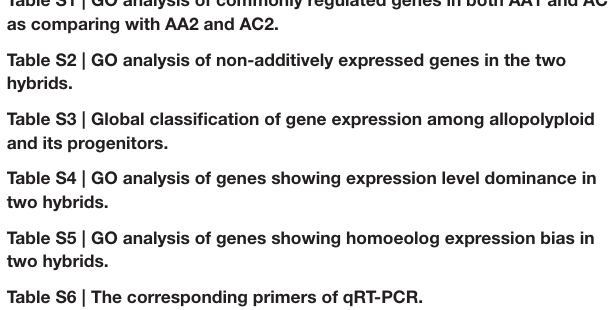
Figure S1 | The overall distribution of non-additively expressed genes along some chromosomes in AC1. The horizontal axis represents the physical location of each chromosome. The vertical axis represents the normalized fold change between AC1 and MPV. The red and blue points indicate the genes over-expressed or under-expressed in AC1 relative to MPV, respectively. Figure S2 | Cross comparisons of sets of additively and non-additively expressed genes in two synthetic hybrids. Numbers of genes shared between different expression patterns are indicated on the cross lines. Figure S3 | Cross comparisons of sets of differentially and non-differentially expressed genes revealed between synthetic hybrids and their relative A genome progenitors. Numbers of genes shared between different expression patterns are indicated on the cross lines. Figure S4 | Global classification of gene expressions among hybrid AC2 and its progenitors. Genes based on differentially or non-differentially among the hybrid, diploid progenitors, and MPV, were further classified into (A) 19 possible expression patterns (I—XIX; AA2 vs. CC, AA2 vs. AC2, AC2 vs. CC) and (B) 9 major expression categories (a–i; AC2 vs. MPV, AA2 vs. CC). Red, green and blue bars represent the confidence intervals of expression level observed in A and C genome progenitors and hybrid, respectively. A gene is differentially expressed between two samples when their confidence intervals (bars) do not overlap whereas it is equal when they do overlap. The x-axis represents the 19 possible expression patterns. The y-axis represents gene count. The number of genes for each expression pattern in each of expression categories is also indicated. Figure S5 | Comparison of the expression levels of genes showing expression level dominance in AC2. (A) The four expression level dominance patterns, for which the gene expression level in hybrid AC2 is statistically similar to one parent but different from the other parent. (B) The normalized expression values, measured in hybrid, the MPV and two progenitors, for genes from the four expression patterns are plotted to illustrate the expression level dominance. The y-axis represents log 2 of the expression level (FPKM). Genes are orders on the x-axis according to increasing FPKM of their MPV. The number of genes in each comparison is also indicated. Different colors indicate different species as described above, Red, AA2; green, CC; blue, AC2; purple, MPV. Figure S6 | qRT-PCR confirmation of the differentially expressed genes. Columns and bars represent the means and standard error from qRT-PCR ( n = 3), respectively. The average gene expression levels from two RNA-Seq replications are indicated on the bottom of each gene. Table S1 | GO analysis of commonly regulated genes in both AA1 and AC1 as comparing with AA2 and AC2. Table S2 | GO analysis of non-additively expressed genes in the two hybrids. Table S3 | Global classification of gene expression among allopolyploid and its progenitors. Table S4 | GO analysis of genes showing expression level dominance in two hybrids. Table S5 | GO analysis of genes showing homoeolog expression bias in two hybrids. Table S6 | The corresponding primers of